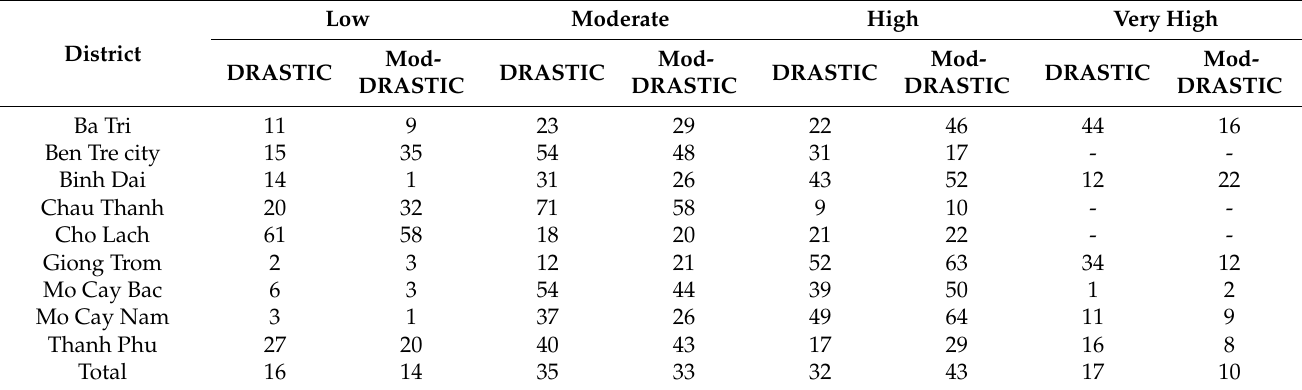
Table 5. The vulnerability level area by district in the study area